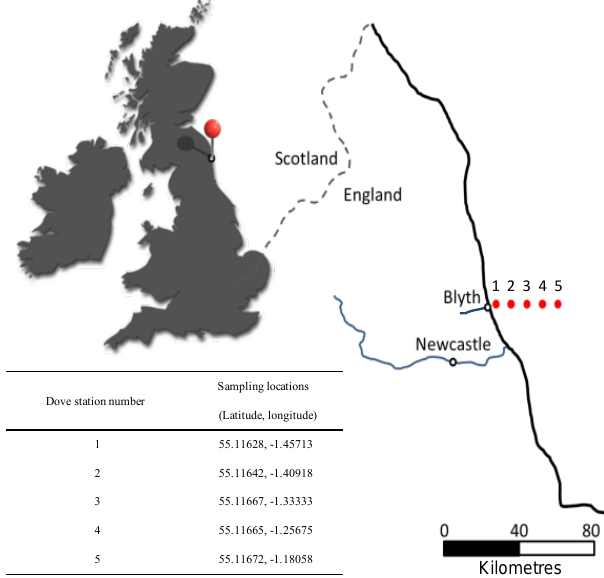
Figure 1. Location map of the Dove Time Series sampling transect 2012–2013 off the coast of Blyth, North East